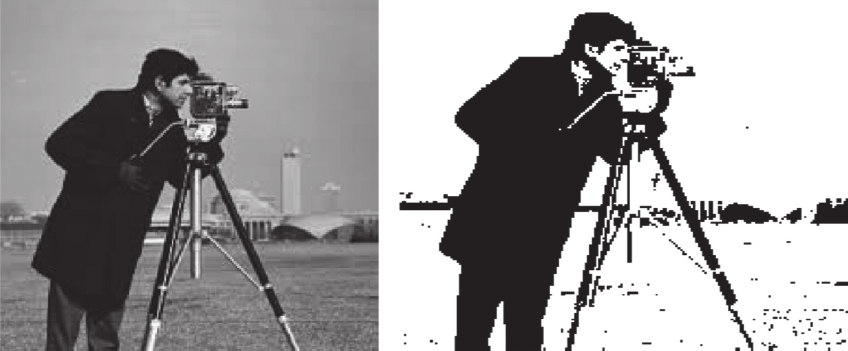
cluster. (c) c cluster 2. (d) c cluster 3. 1 2 3